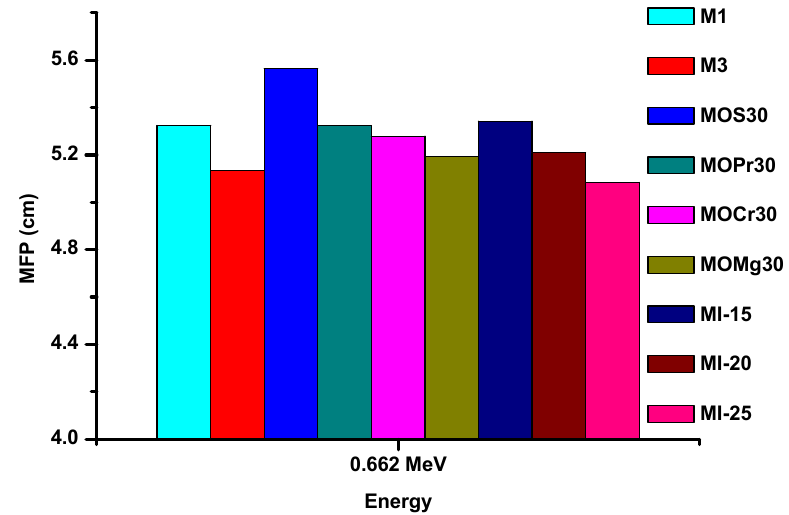
Figure 10. The MFP of prepared samples compared with other related literature.